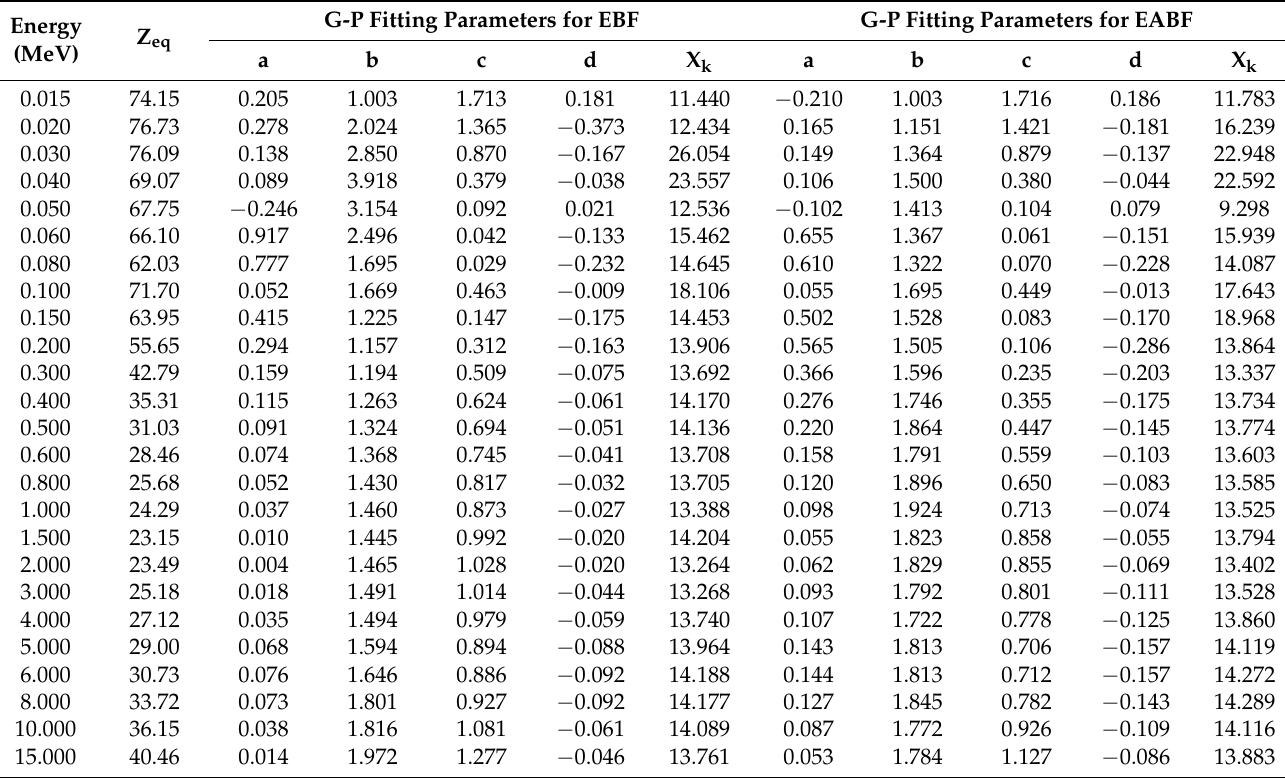
Table 3. (EBF and EABF) G–P fitting coefficients (b, c, a, Xk and d) of LPb50B glass sample.